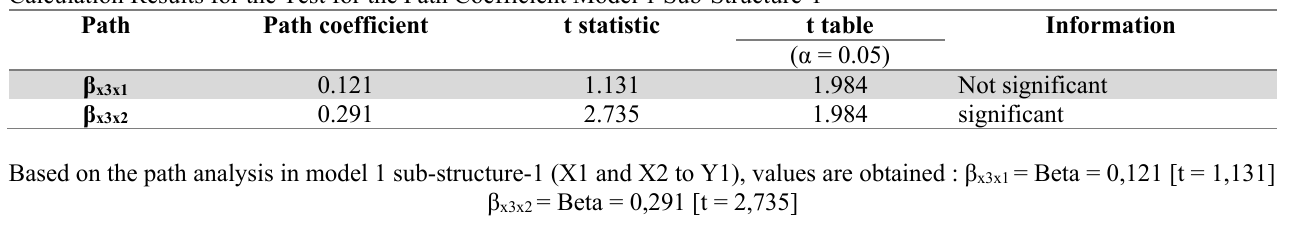
Calculation of Path Coefficient in Sub-Structure 1